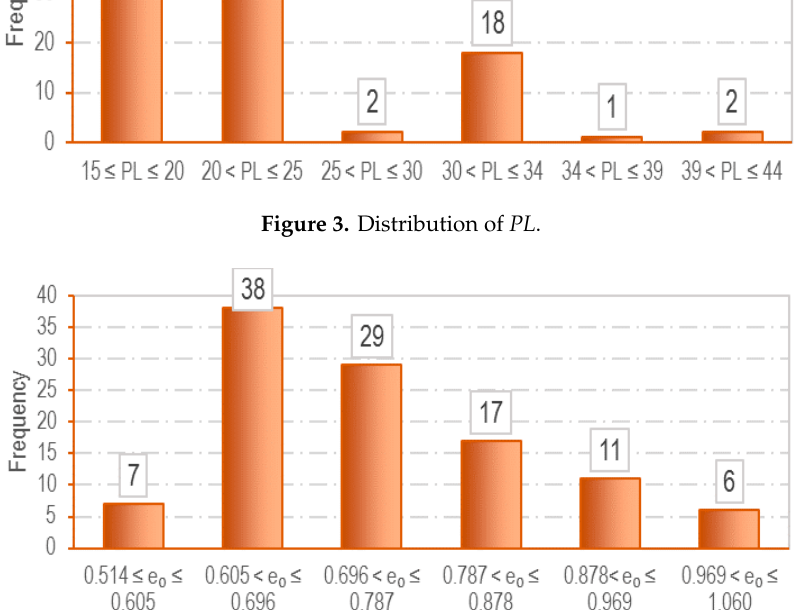
Figure 4. Distribution of e o .